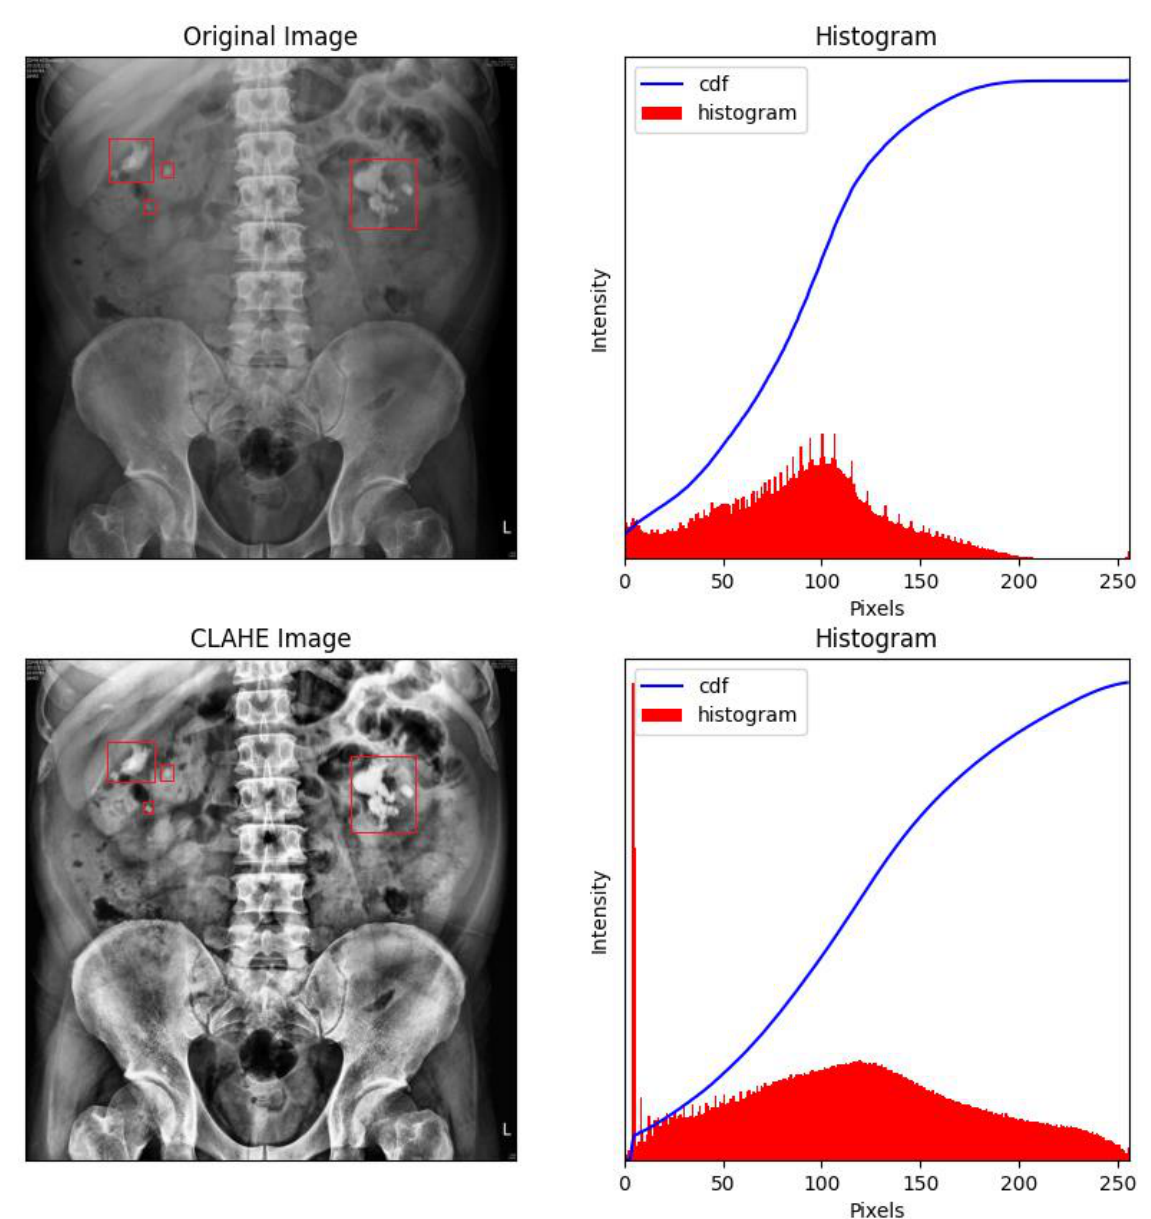
Figure 7. Contrast-limited adaptive histogram equalization (CLAHE) of a KUB image. It can clearly